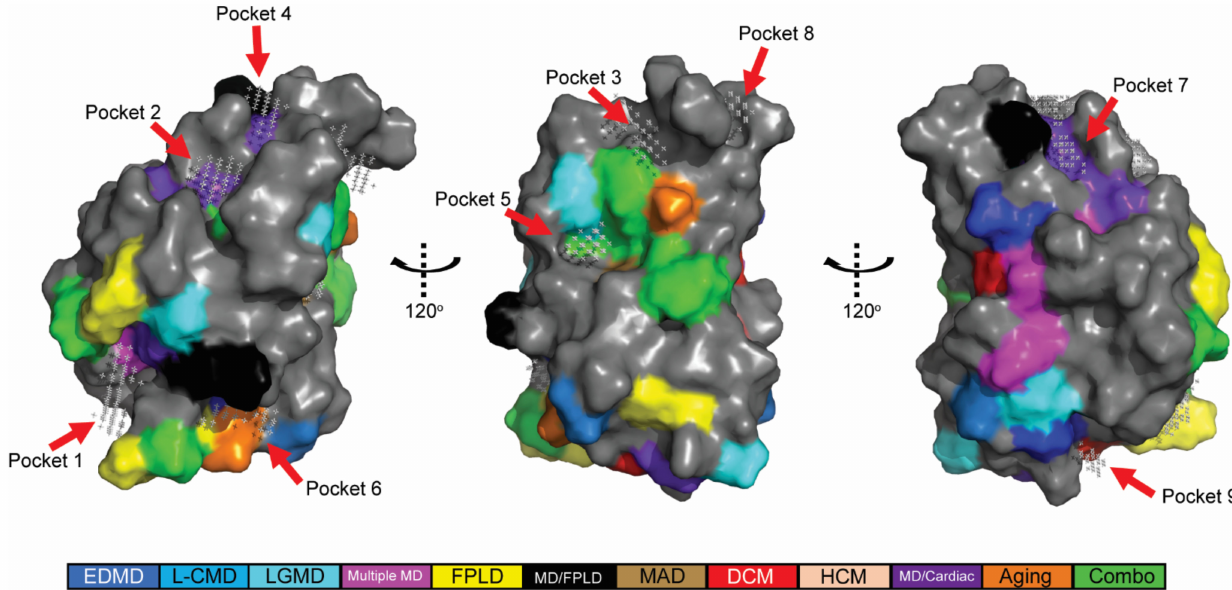
Figure 2. Predicted protein binding pockets in the Ig-like fold domain map to positions of disease-related amino acid substitutions. A surface model of the Ig-like fold domain (PDB: 1IVT; gray) is shown with the position of disease-related amino acid substitutions indicated by colors (color code bar below). Protein partner binding pockets (white hashes) were predicted by POCASA v1.1 [43]. 7/9 are overlaid on the surface